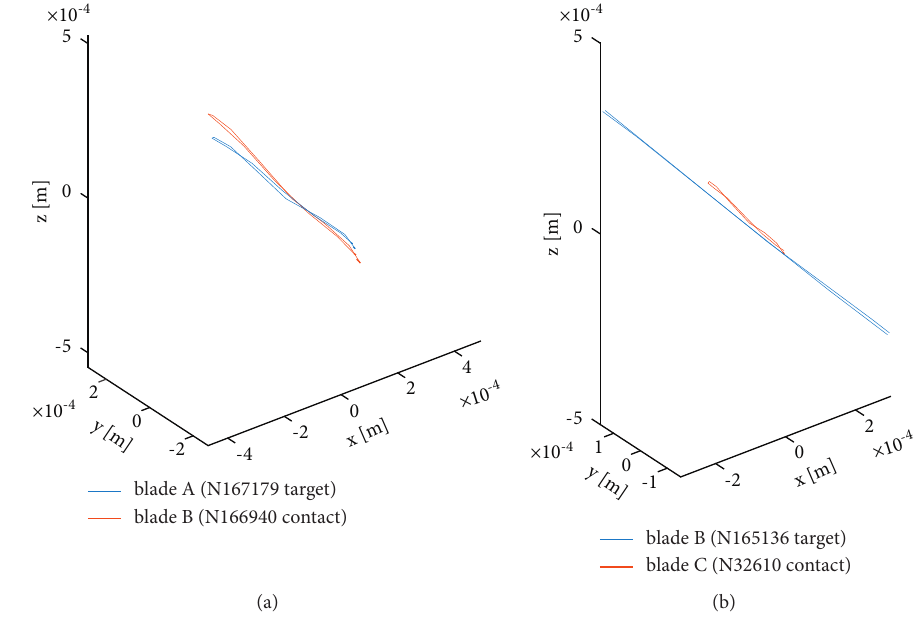
Figure 16: Trajectories of blade motions at contact-target pair nodes in the middle of contact surfaces—6ND data and do not start from time zero. Marks on the lines denote the peaks of the amplitude of harmonic attenuation.